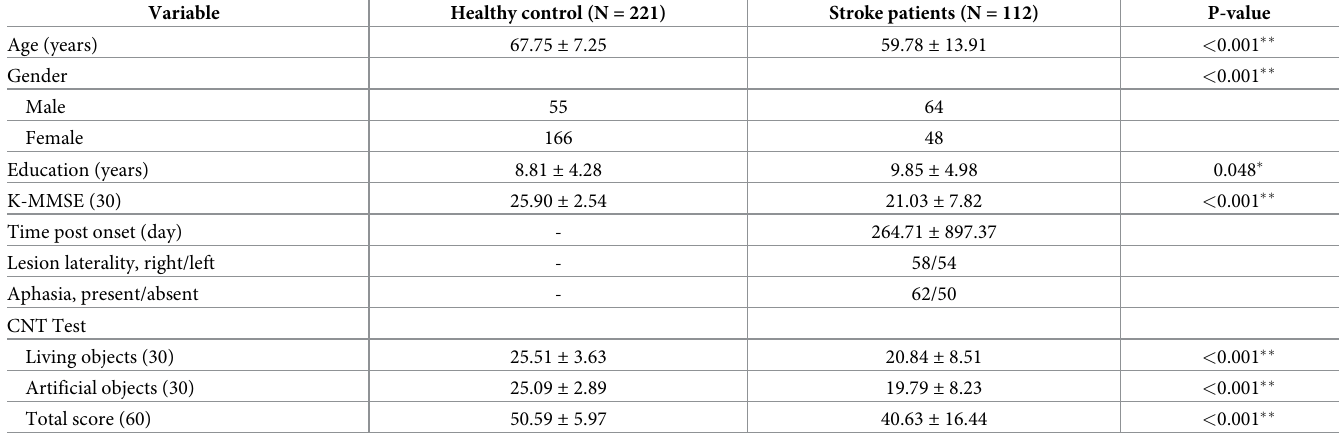
Table 1. Comparison of variables between healthy controls (N = 221) and stroke patients (N =